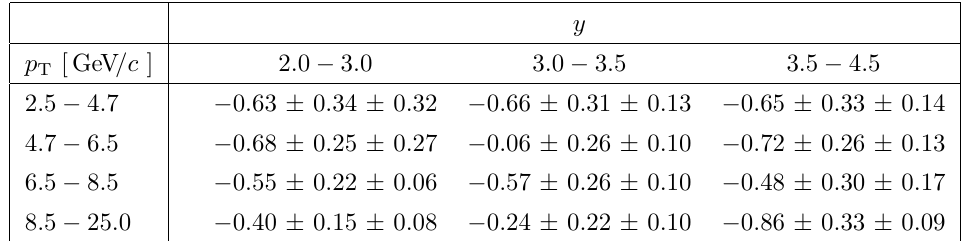
Table 2 . Values of the D + production asymmetry in percent, including, respectively, the statistical s p and systematic uncertainties for each of the D + kinematic bins using the combined s = 7 and s 8 TeV data sets. The statistical and systematic uncertainties include the corresponding contributions from the detection asymmetries, and are therefore correlated between the